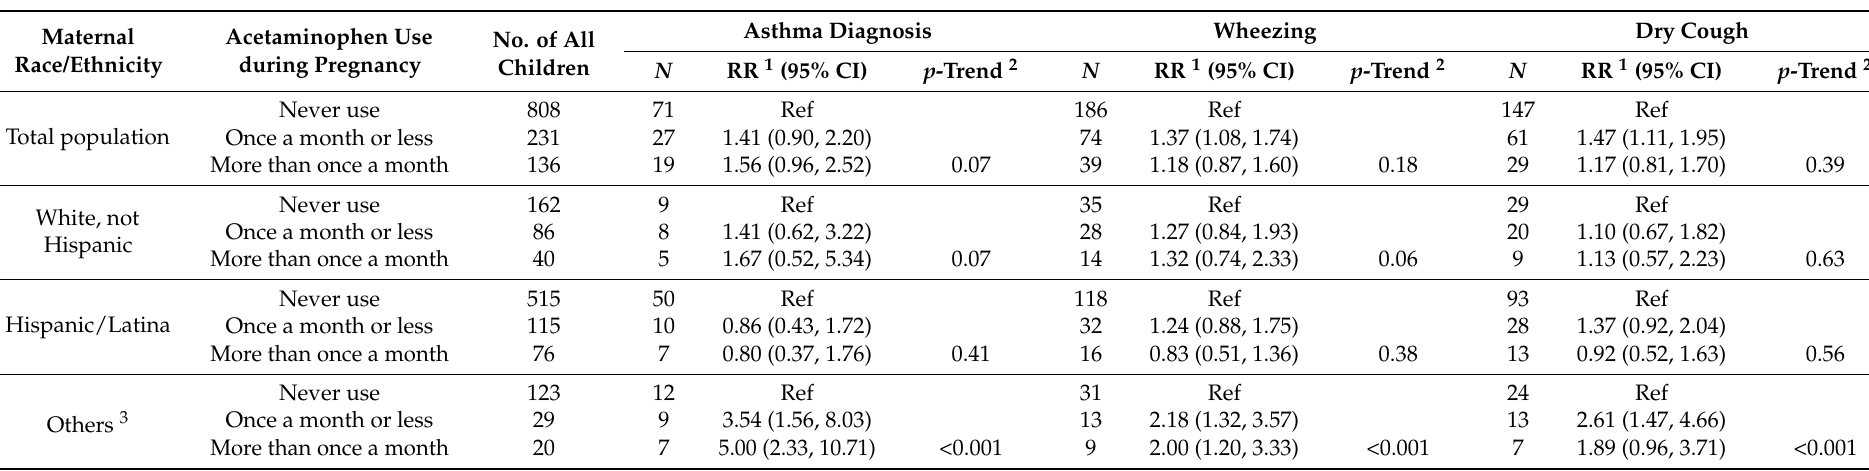
Table 3. Risk ratio (RR) and 95% confidence interval (CI) for asthmatic outcomes in early childhood according to the frequency of maternal prenatal acetaminophen use. Maternal